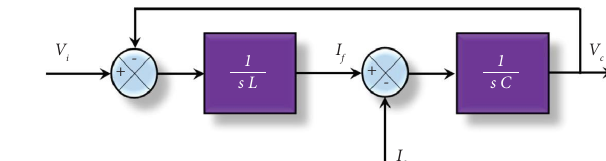
Figure 6: Applied FCS-MPC control for an ILC of HMG.